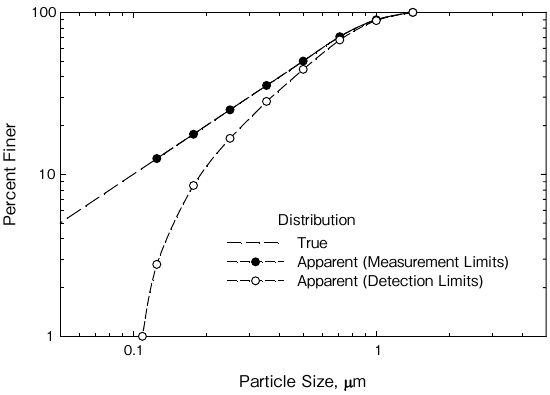
Fig. 1 The effect of lower size limits on size distribution